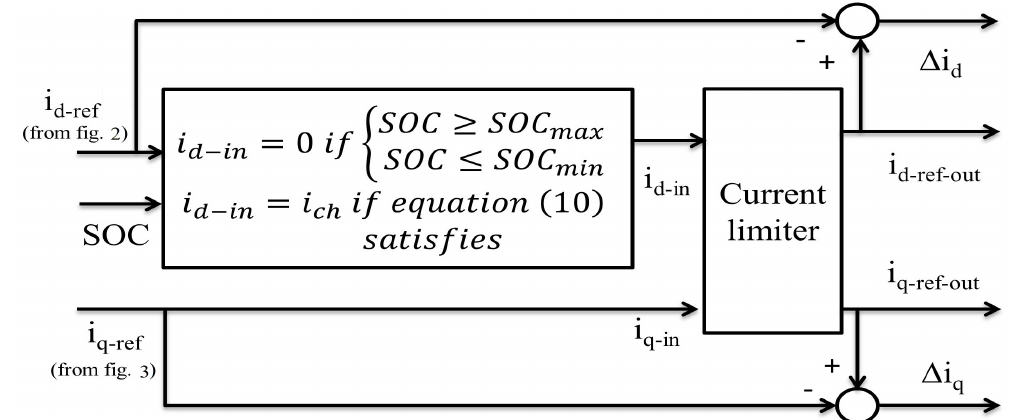
Figure 4. Block diagram of BESS charge/discharge